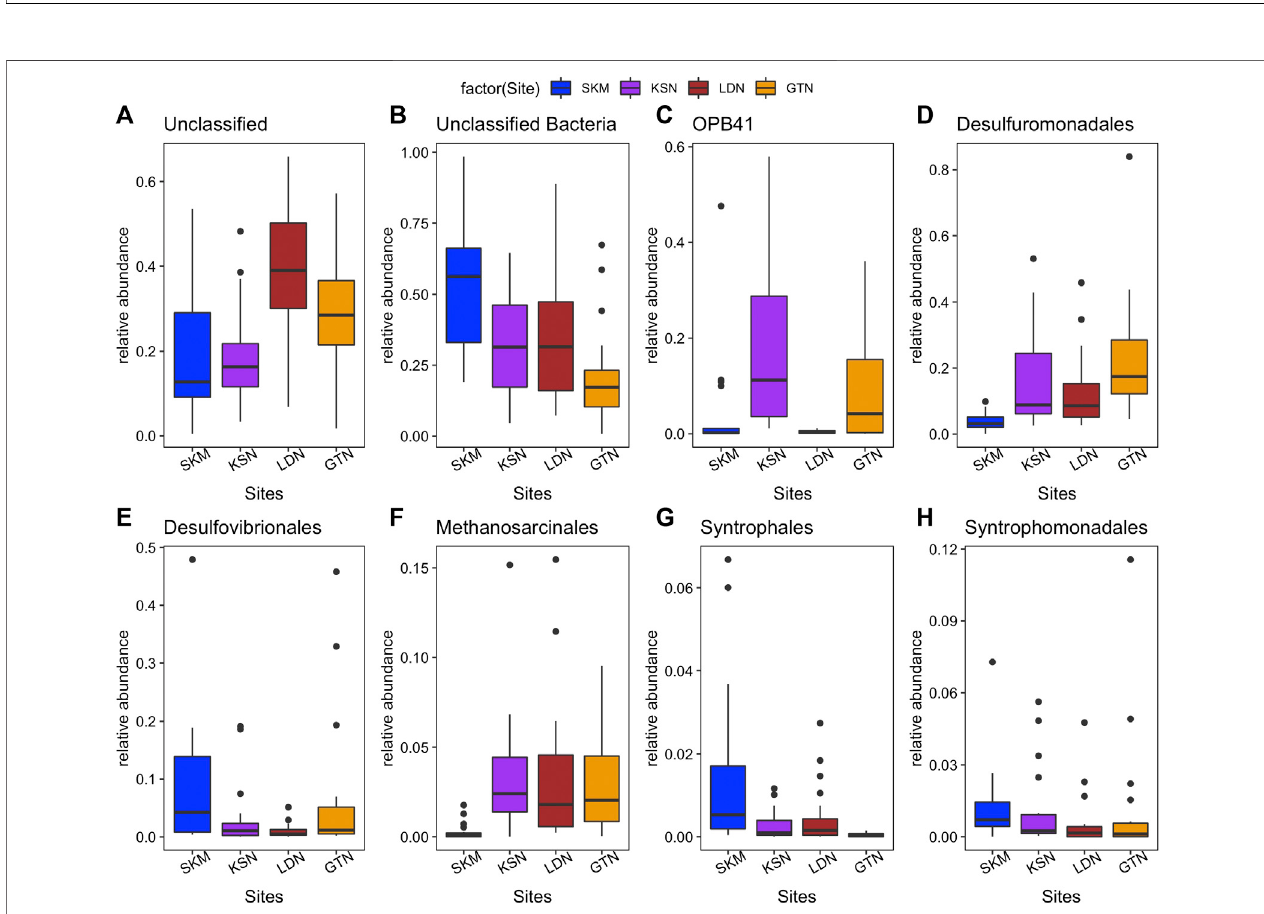
Frontiers in Environmental Science |